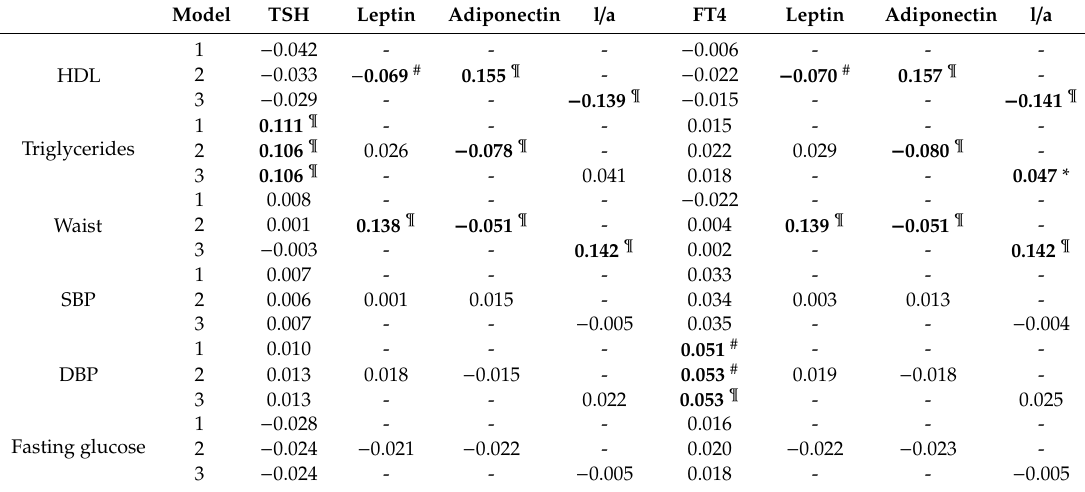
Table 4. Association of thyroid function with components of the metabolic syndrome in male.